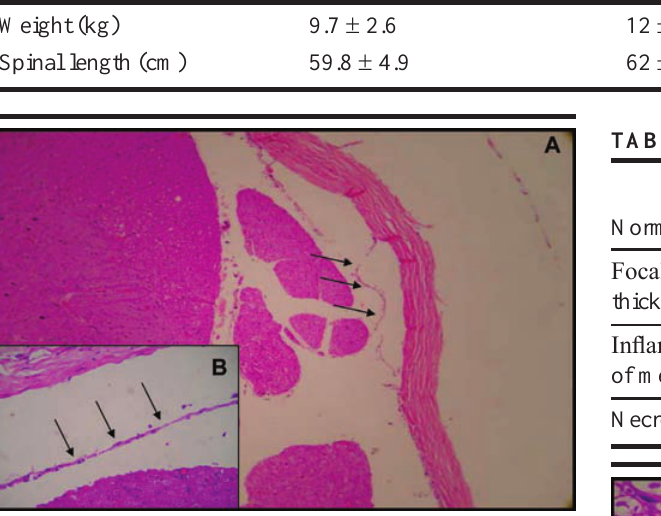
FIGURE 1 - Group 1 (saline solution). Segment of nerve